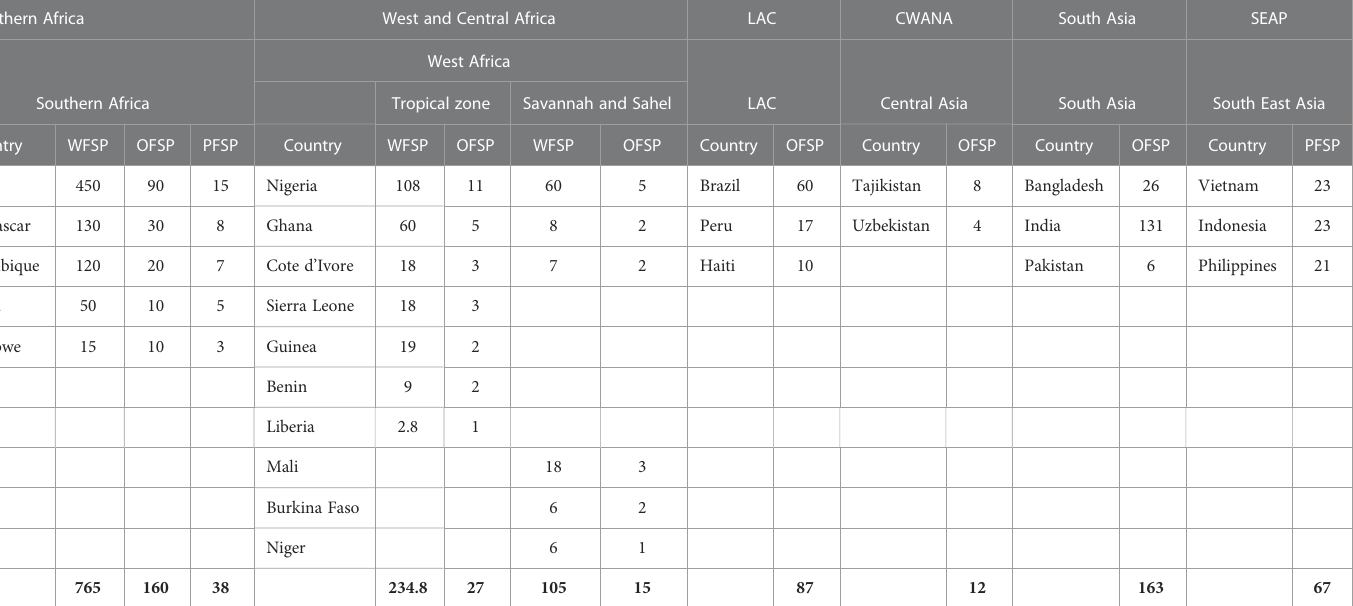
Values are in thousands of hectares. LAC, Latin America and the Caribbean; CWANA, Central and West Asia and Northern Africa; SEAP, South East Asia and the Paci fi c; WFSP, White- fl eshed Sweetpotato; OFSP - Orange- fl eshed Sweetpotato; PFSP, Purple- fl eshed